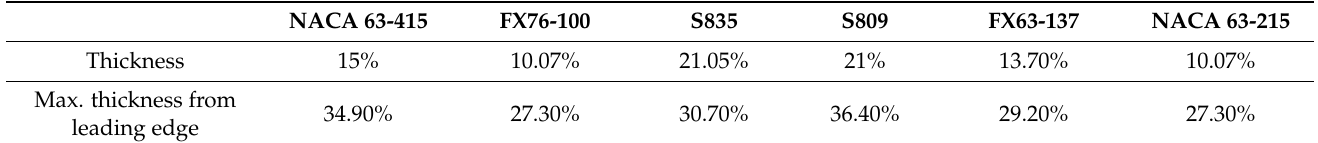
Table 1. Thickness and maximum thickness for